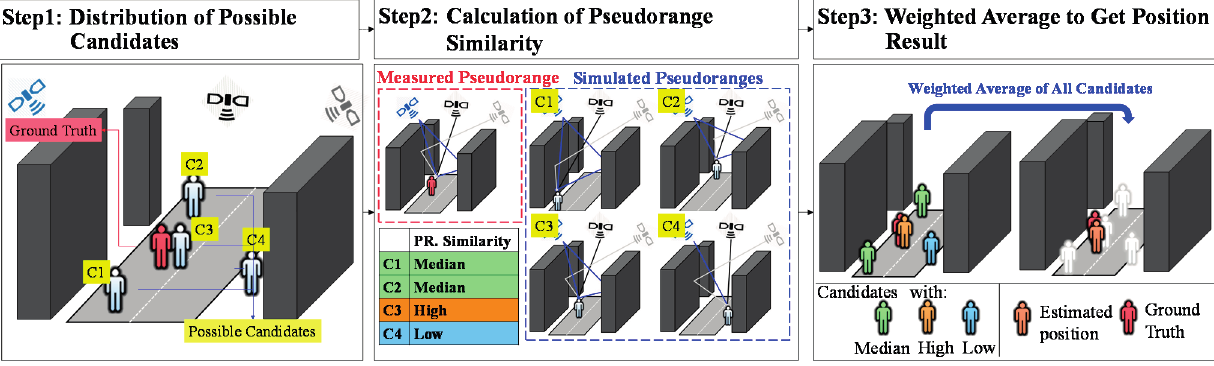
Figure 1. The idea of the developed 3D building model based positioning